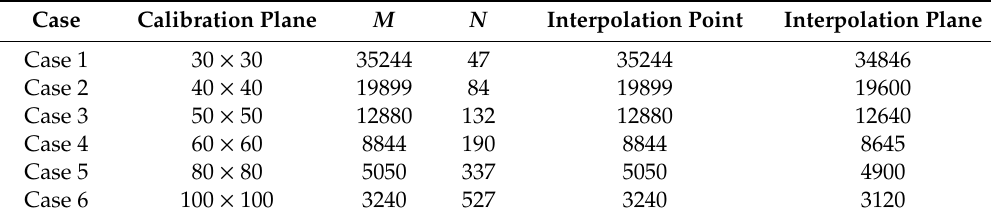
Table 2. The number of point groups, interpolations points, and planes for cases 1–6.